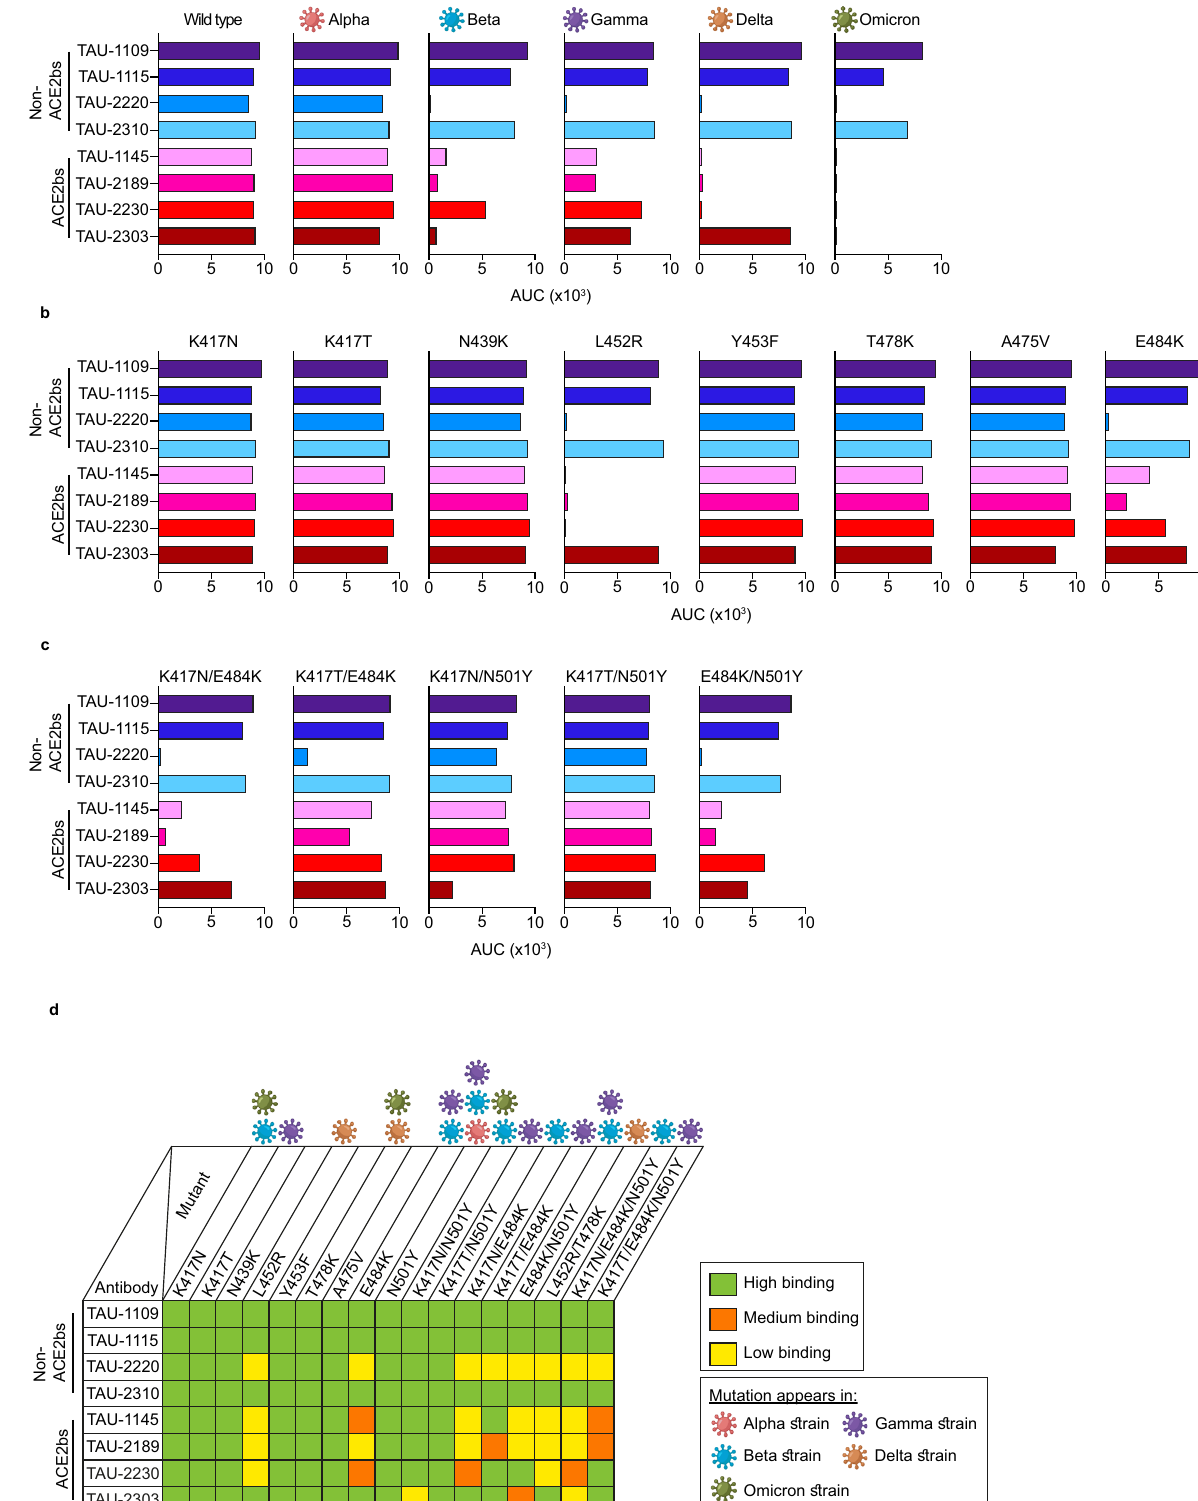
Fig. 1 Antibody binding to the RBD of wild type and SARS-CoV-2 VOCs by ELISA. ACE2bs or non-ACE2bs antibodies are indicated to the left of each panel, a – d . For panels a – c , each graph represents antibody binding to wild type or VOC ( a ), single ( b ) or double ( c ) mutant RBD. AUC was calculated by GraphPad Prism. The raw OD 650 values, as well as isotype control, are presented in Supplementary Fig. 1. Each experiment was repeated at least three times ( n ≥ 3). d Summary of the antibody binding af fi nity to each RBD generated in this study. Green color indicates binding af fi nity of >75%, orange of 25 – 75%, and yellow of <25% as compared to wild type RBD. The VOCs harboring each mutation are